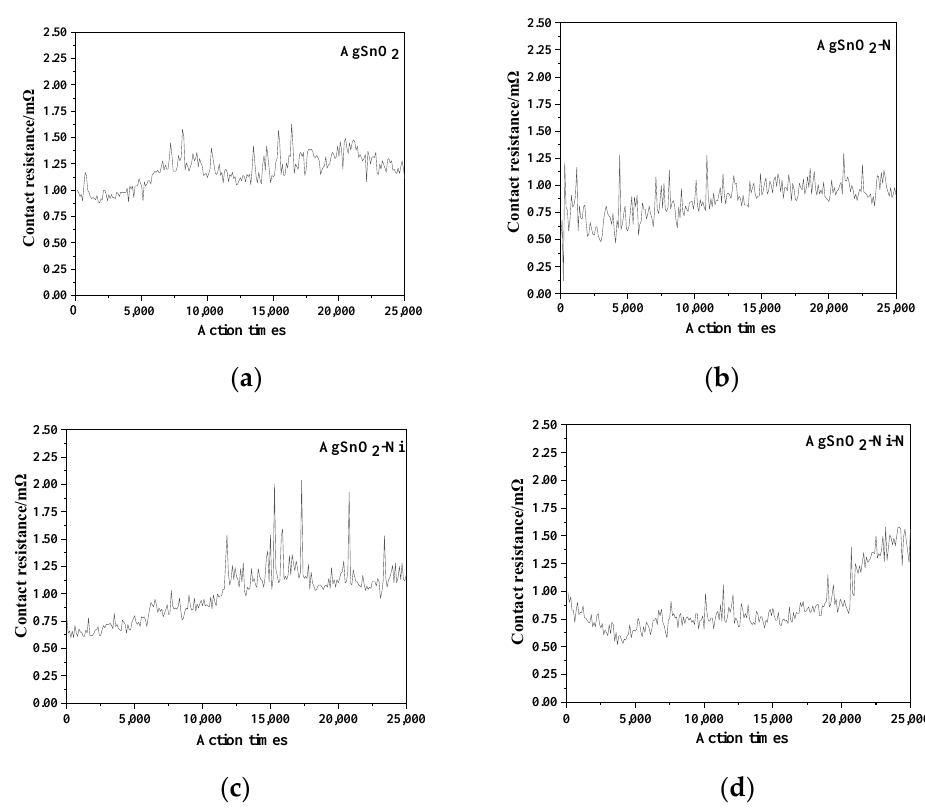
Figure 7. Contact resistance: ( a ) SnO 2 ; ( b ) SnO 2 – N; ( c ). SnO 2 – Ni; ( d ). SnO 2 – Ni – N.